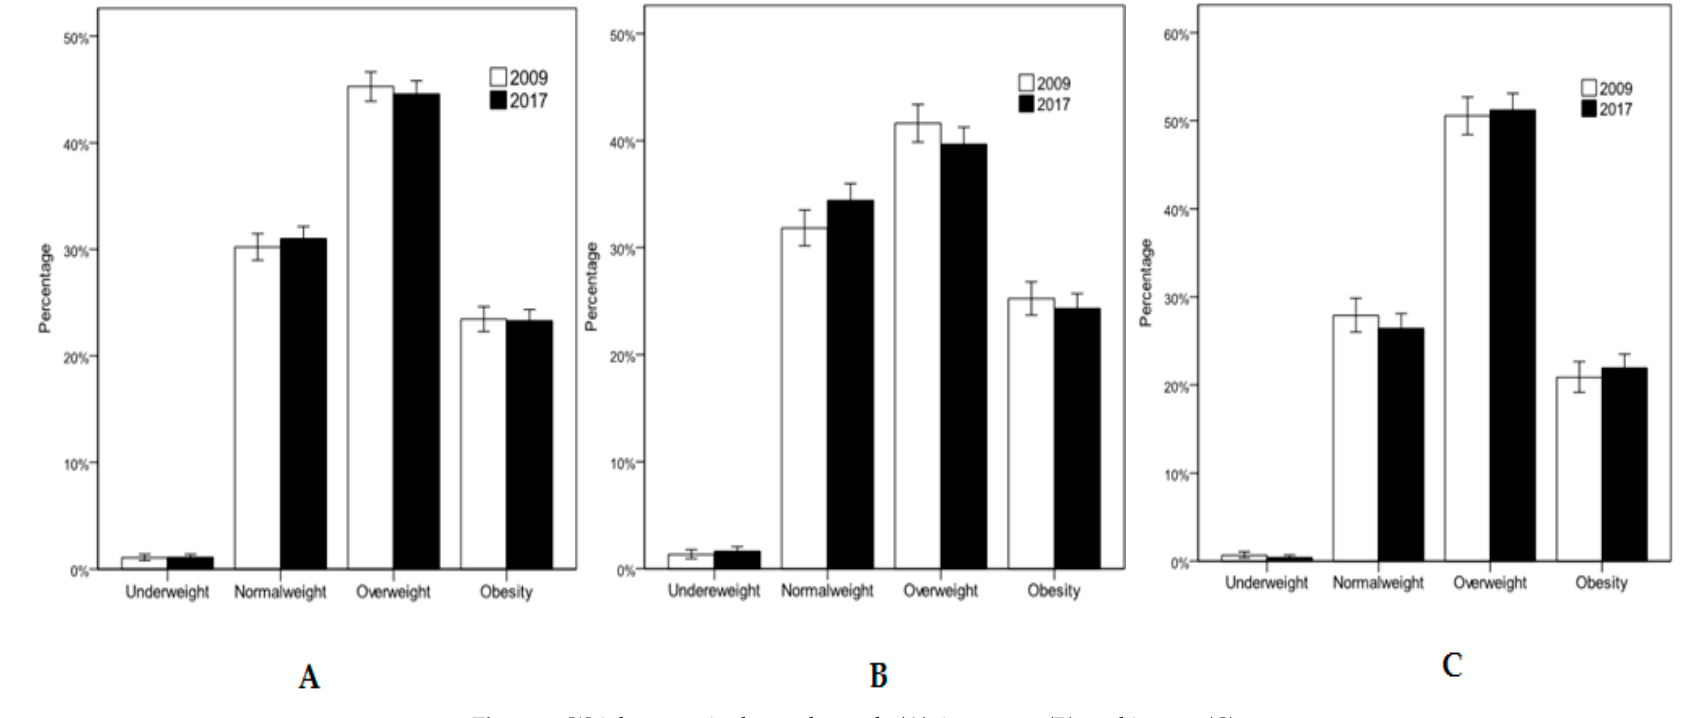
Figure 1. Weight status in the total sample ( A ), in women ( B ), and in men ( C ). Table 3. Age, BMI, disease or chronic health problems, number of diseases, and self-perceived health status regarding survey year, age group, and sex.